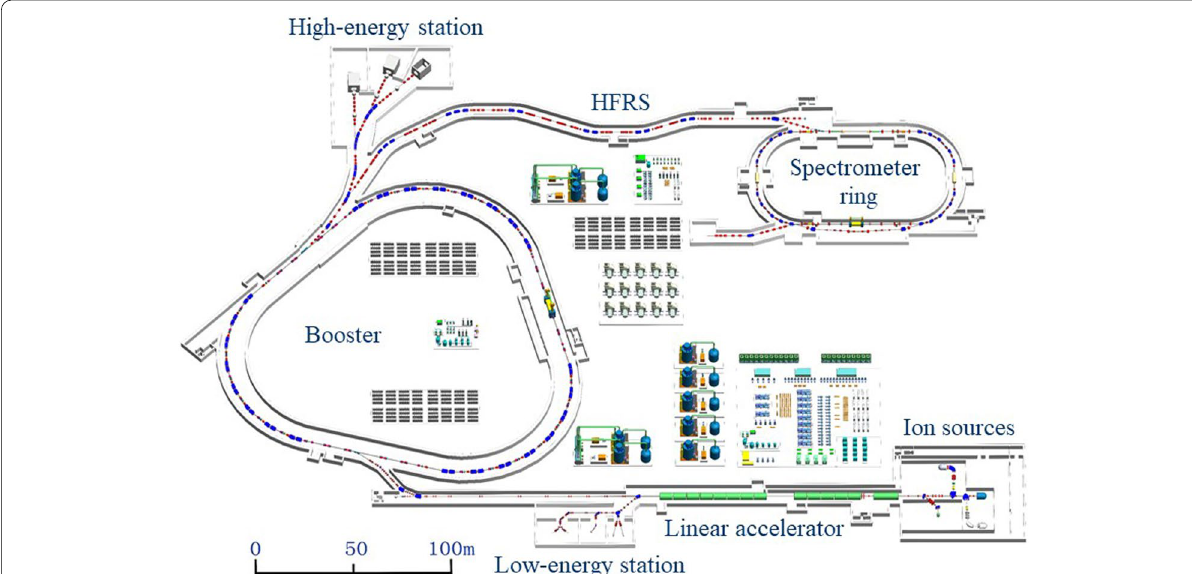
Fig. 2 Layout of HIAF. The major sub-systems are sketched, including the ion sources, the superconducting ion linear accelerator, the high-energy synchrotron booster, the high-energy fragment separator, and the experimental spectrometer ring. The low-energy and high-energy experimental stations are also indicated